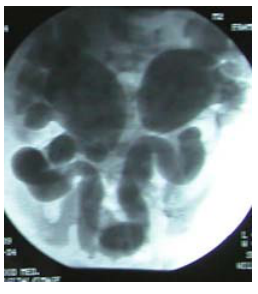
FIGURE 8 . VCU demonstrating bilateral grade 5 VUR